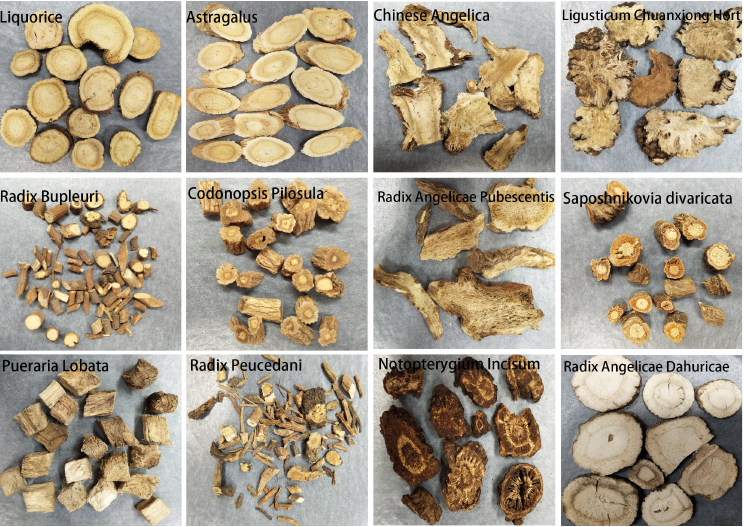
Figure 2. Physical appearances of the 12 categories of herbal